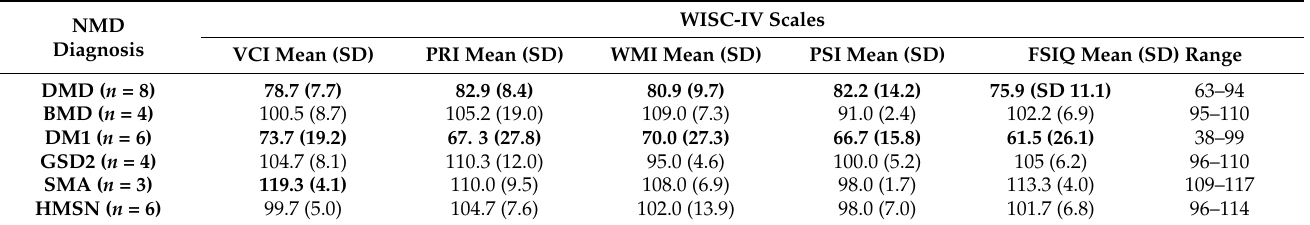
Table 2. NMDs-related Wechsler Intelligence Scale for Children, Fourth Edition (WISC-IV) sub-indices and full-scale intelligence quotient (FSIQ) scores.